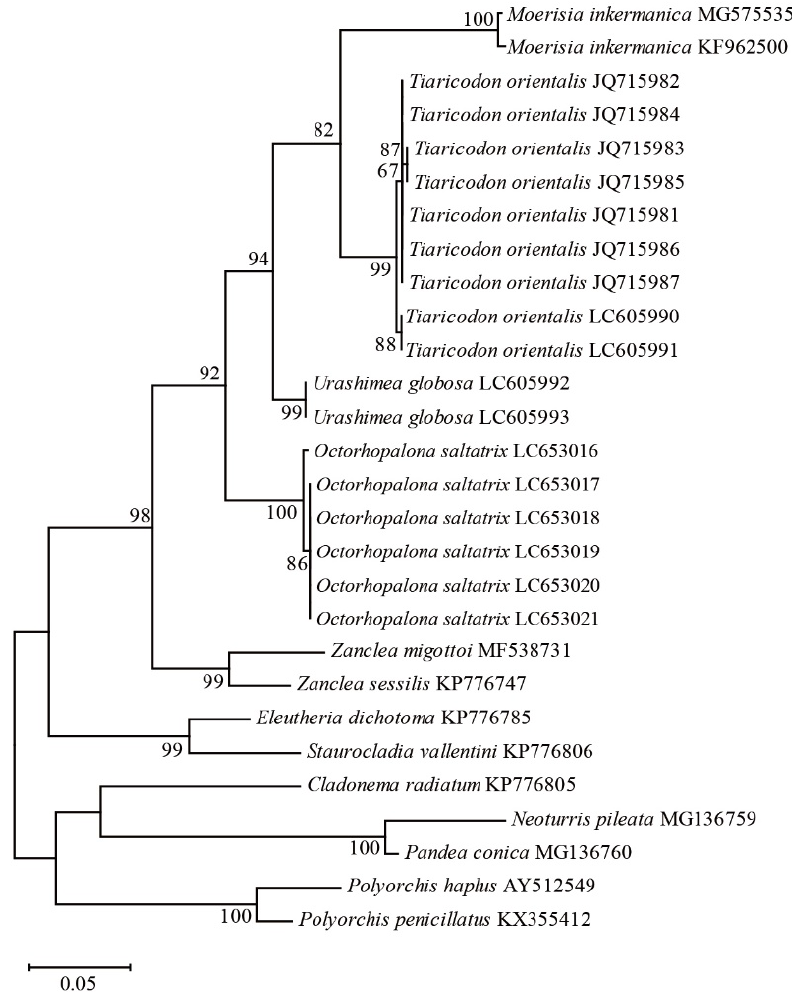
Figure 3. Nuclear 16S rDNA maximum-likelihood tree for 13 anthoathcata taxa based on the General Time Reversible model: Scale bar indicates branch length in substitutions per site. Nodal support values are presented as the ML bootstrap value; only values >50% are shown.